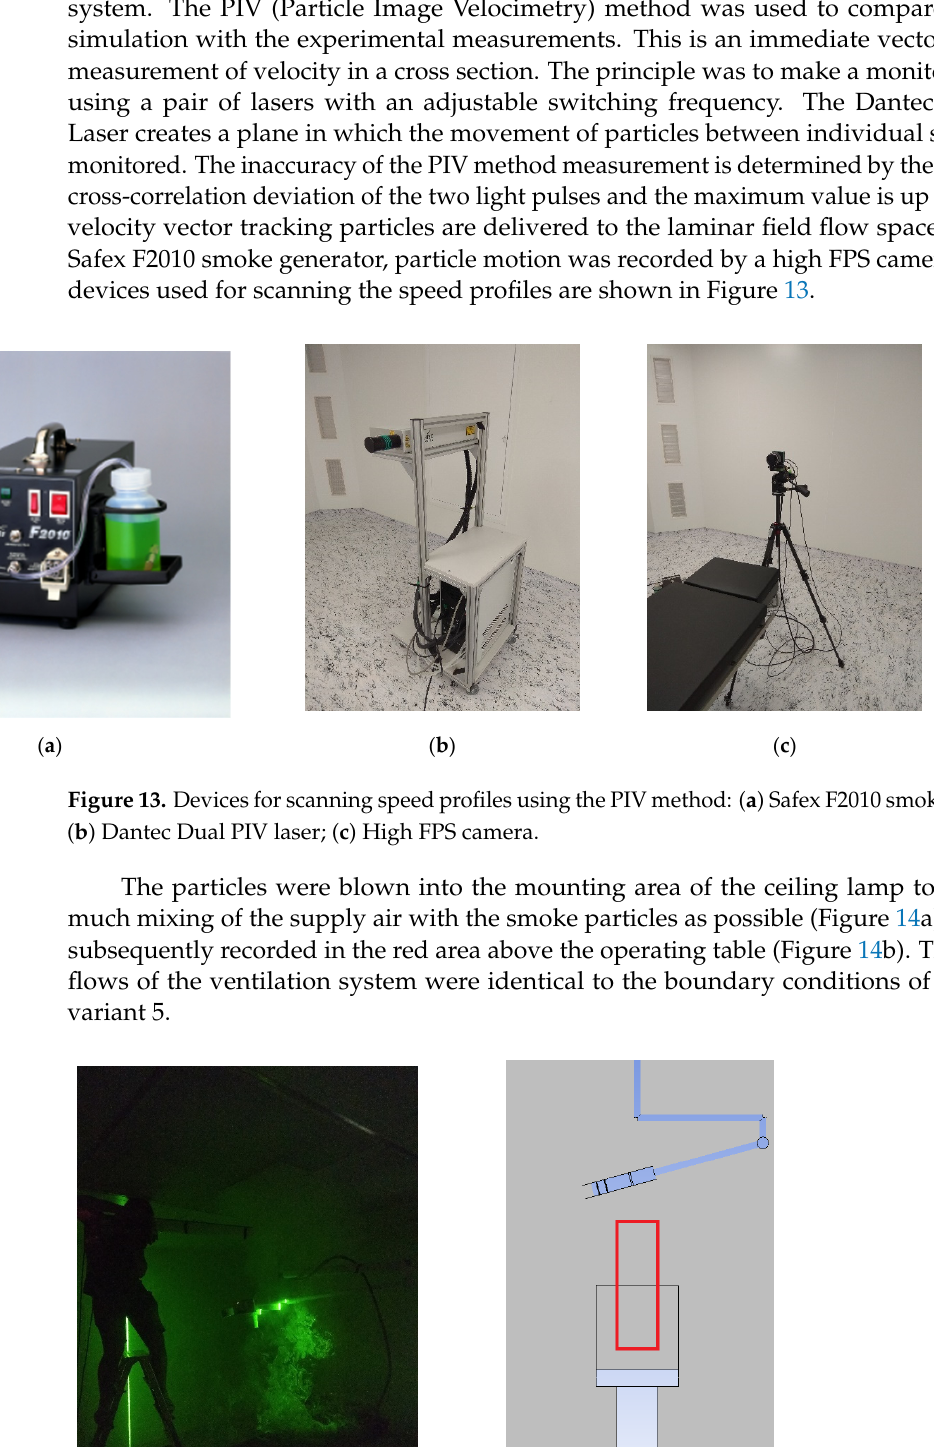
Figure 12. Air velocity vectors at V IT 2 reference volume.